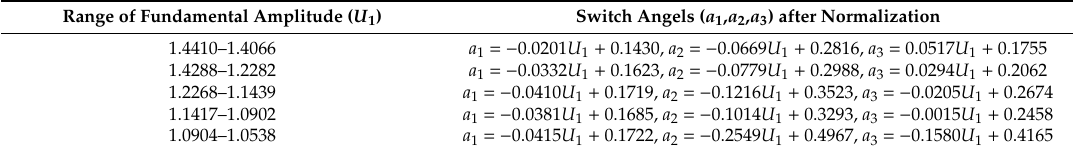
Table 5. Results of B waveband switching angles.